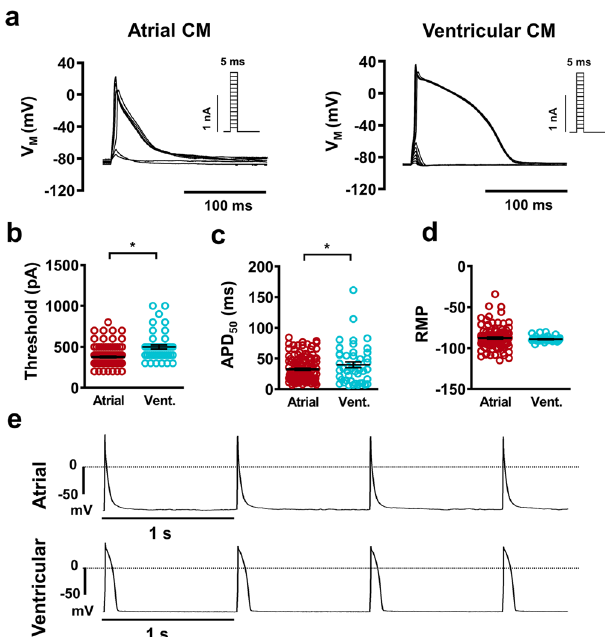
Fig. 4 Action potential (AP) acquisition from native atrial and ventricular cardiomyocytes (CM) using automated patch-clamp. a Representative traces membrane voltage ( V M ) showing atrial and ventricular (vent.) triggered APs during successive increases in pulse current injection. Insets: current protocol. b Current at which AP take-off was fi rst observed. c AP duration at 50% repolarization (APD 50 ). d Resting membrane potential (RMP) quanti fi cation. e Representative traces of AP trains at 1 Hz show stable RMP between pulses. Data are mean ± SEM. *P < 0.05 vs. ventricular. n = number of atrial (127) and ventricular (45) CMs from 3 animals ( b – d